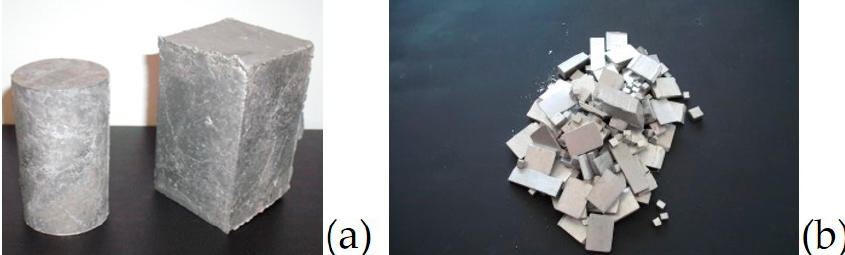
Figure 11. Foam parts (rectangular block: 80 × 50 × 50 mm 3 ; cylindrical foam: 30 mm in diameter and 60 mm in height) ( a ) fabricated using rejected precursor pieces ( b ).